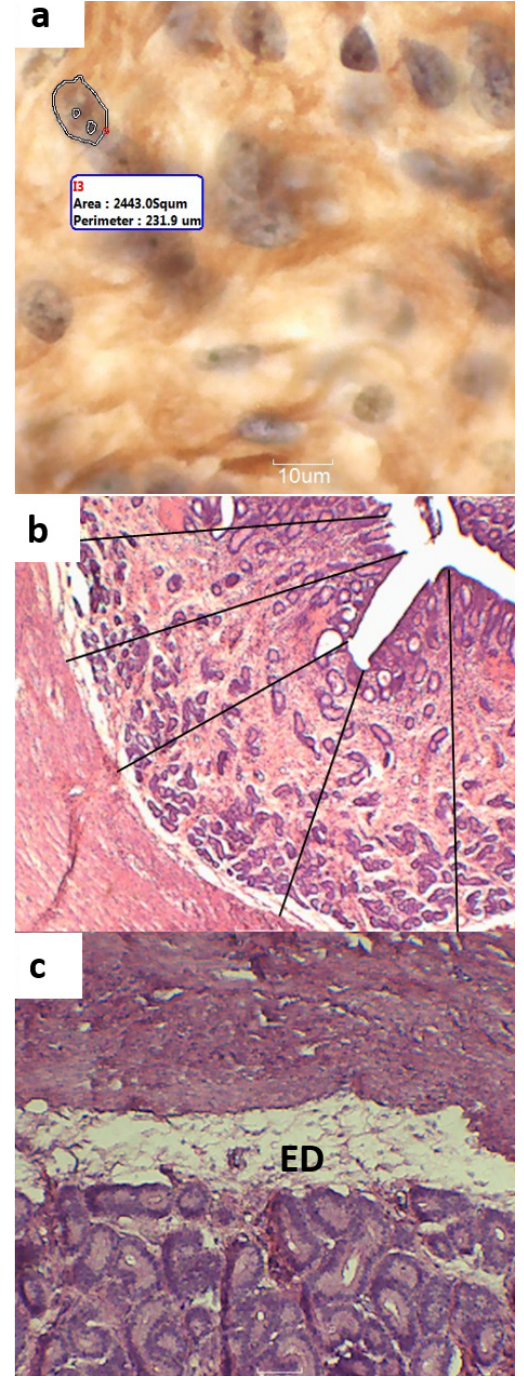
Figure 2 - Photomicrographs: ( a ) nucleolar organizer regions (NORs) at 10 days post ovulation increased 1000x; ( b ) endometrial thickness measurements of the uterine horn increased 40x ( c ) edema (ED) at 10 days post ovulation increased 100x. AgNOR ( a ) and hematoxylin-eosin staining ( b and c